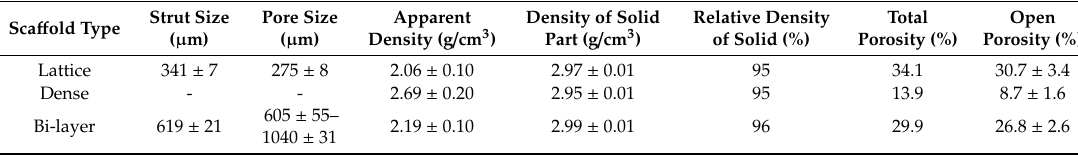
Table 2. Physical characteristics of di ff erent 3D structures.